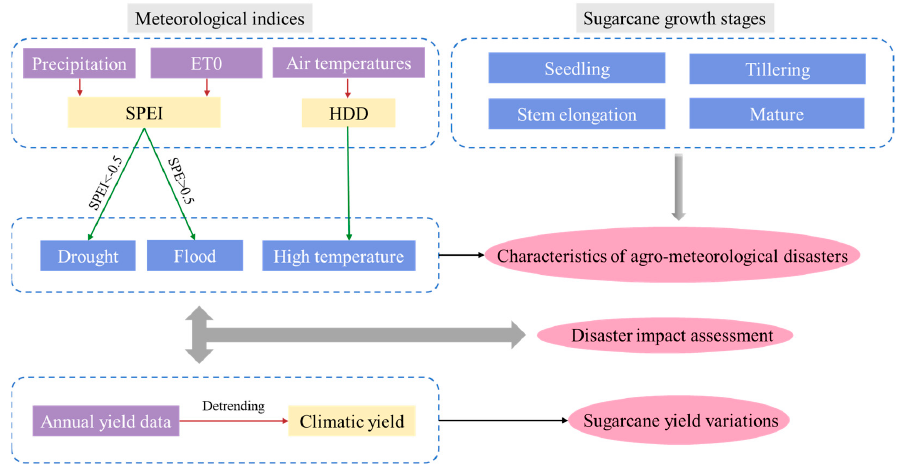
Figure 3. Methodological diagram.